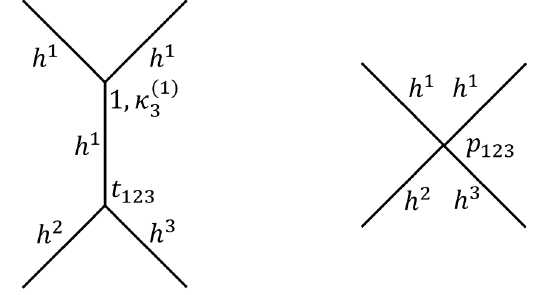
Figure 13 . Leading Feynman diagrams for elastic scattering h 1 h 2 → h 1 h 2 in a bi-field or multi- field Λ cycle theory. 3